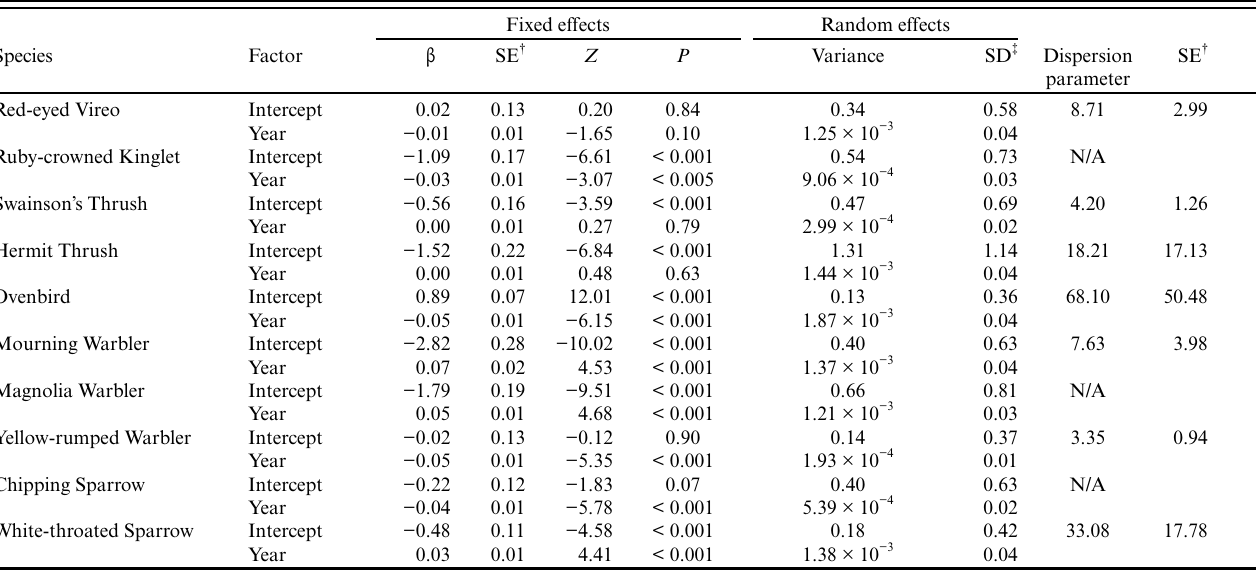
Table 5. Generalized linear mixed effects model results examining variation in abundance of 10 species of passerine between circa 1994 and 2014 in aspen-dominated mixedwood forests of central Saskatchewan.